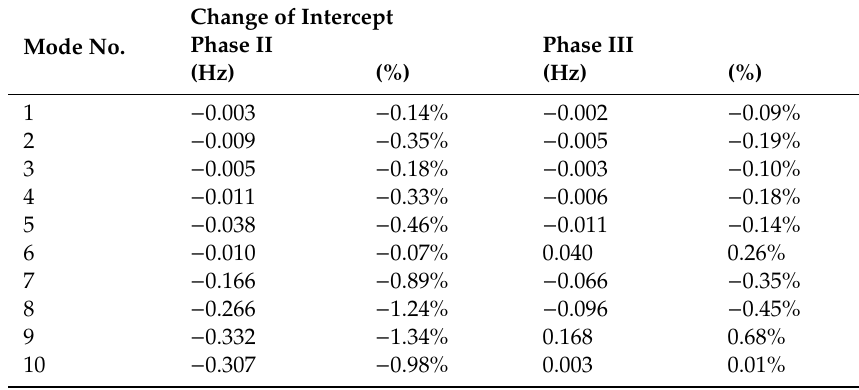
Table 3. The change of intercept of the first-degree polynomial equations for each modal frequency using the first phase as